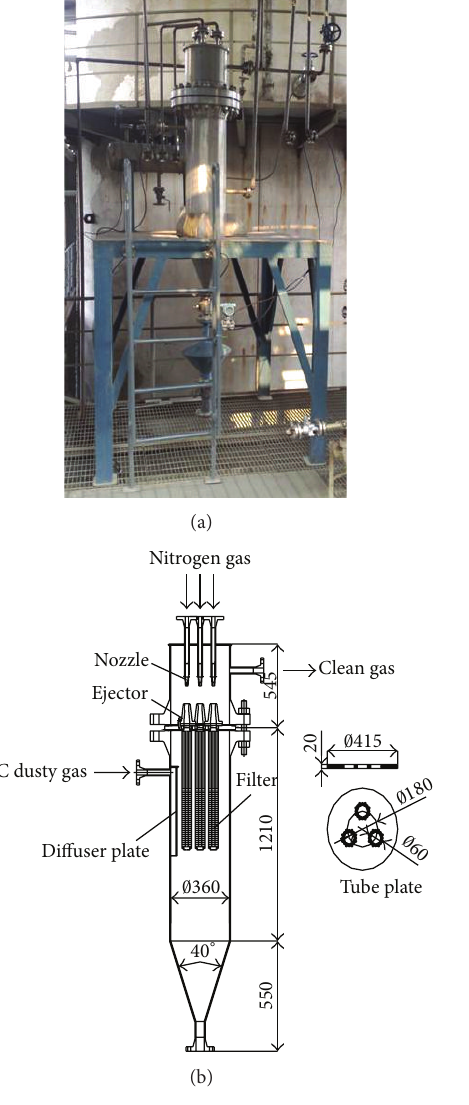
Figure 5: The variations of pressure drop during operation.